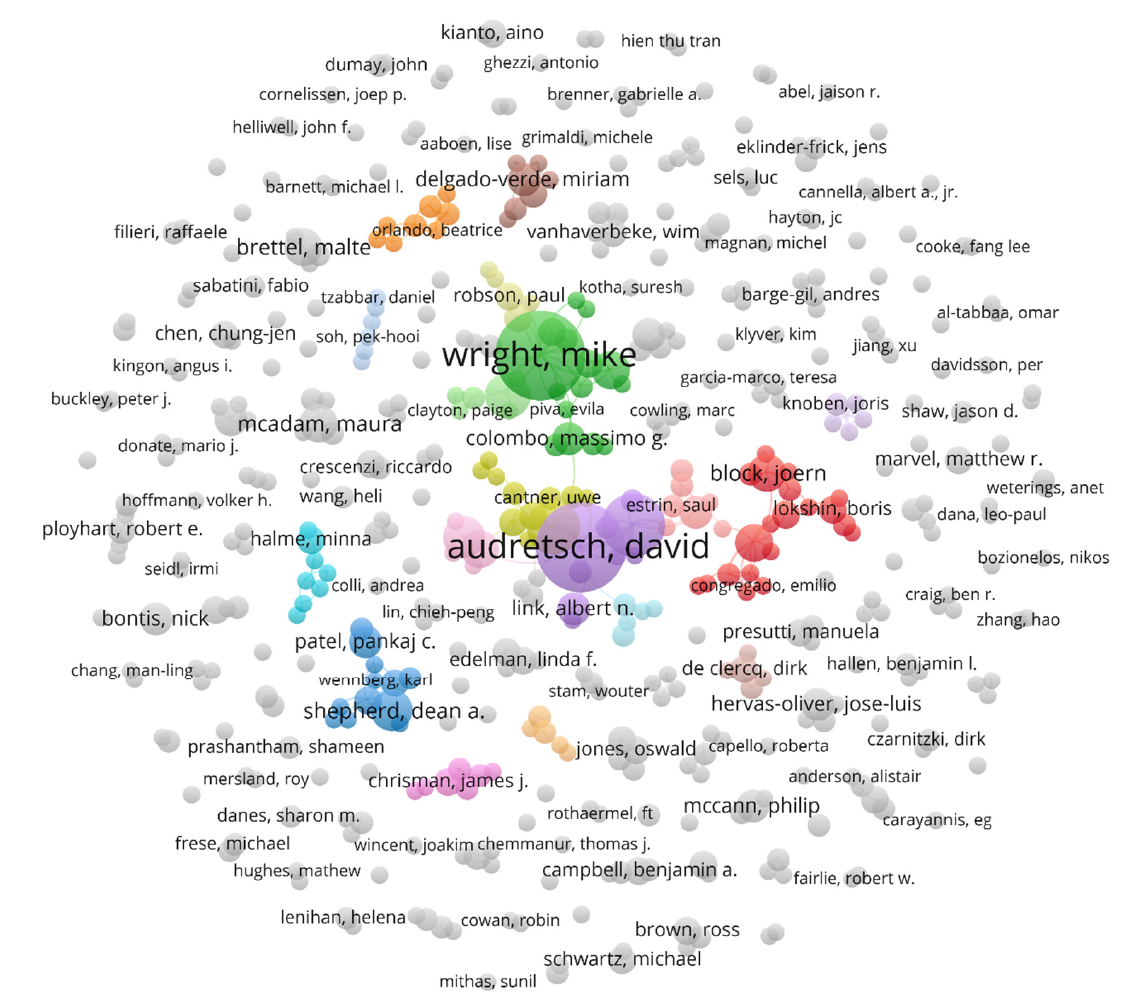
Figure 6. Authors and co-authors participating most often in the 1614 publications (Source: Own elaboration using the VOSviewer software).